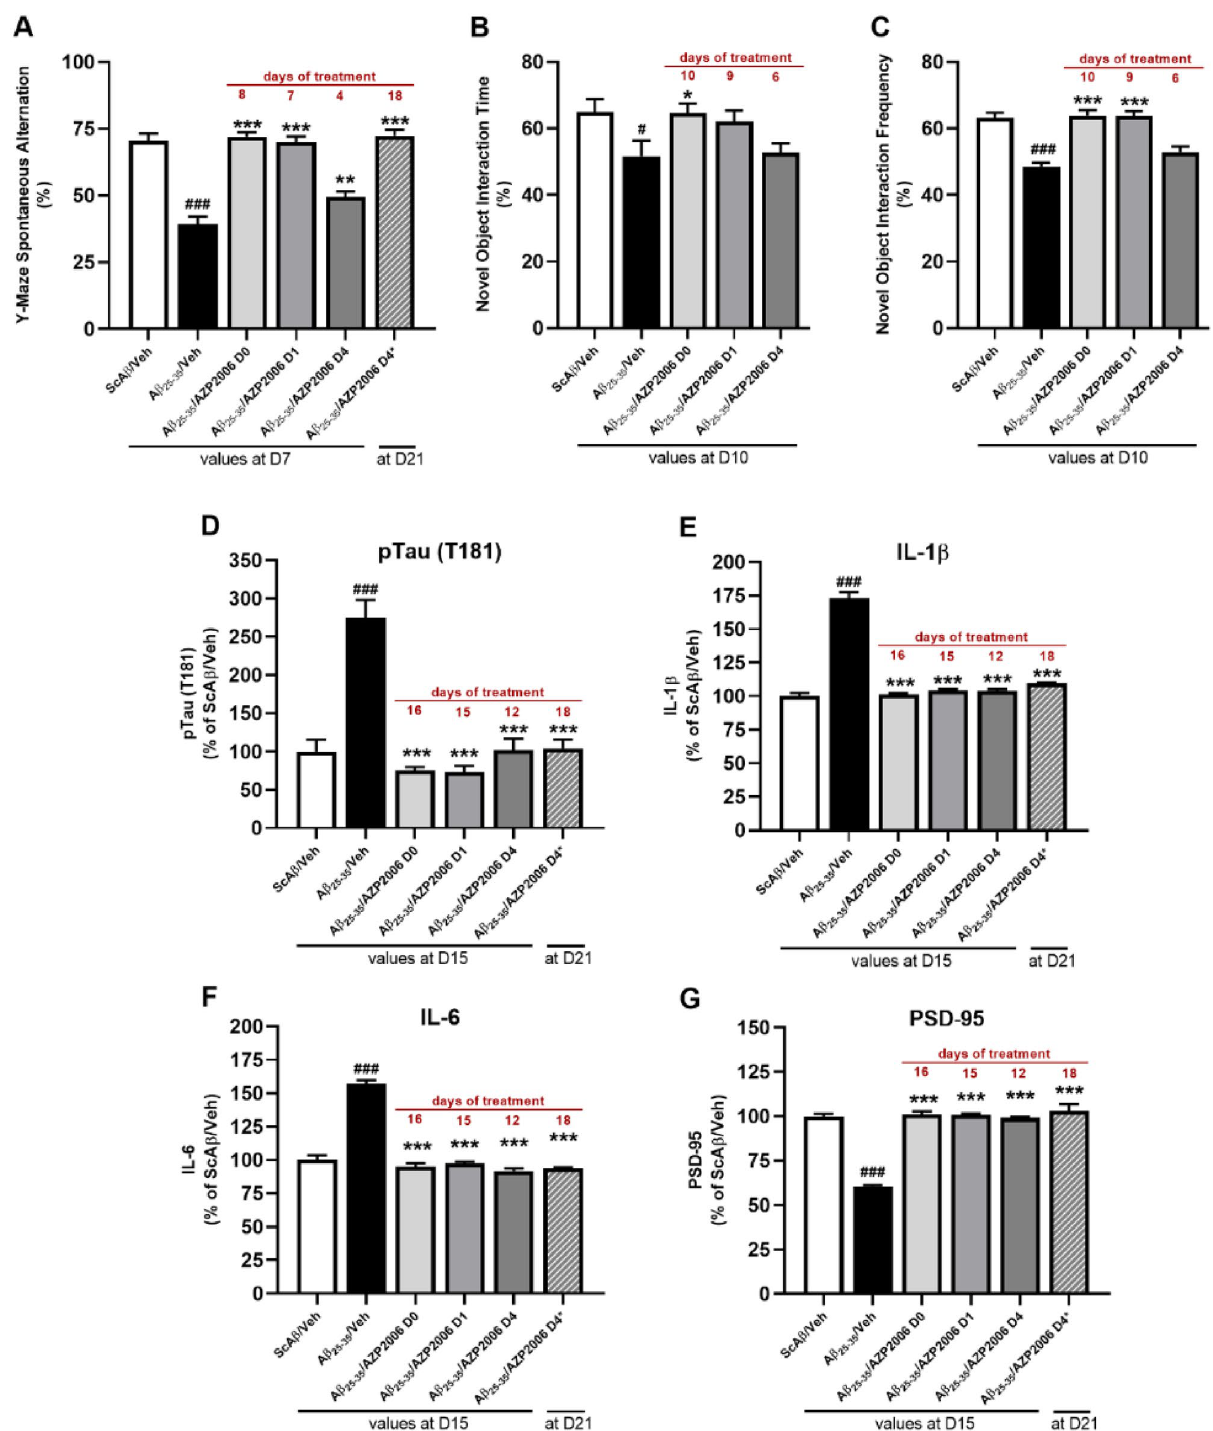
Figure 4. Effect of AZP2006 treatment on Aβ 25–35 injured mice. (A – C) Effect of AZP2006 on learning and memory impairments in the C57B/6Rj mice injured by Aβ 25–35 injection. Mice were daily treated with vehicle (water, D0) or AZP2006 by gavage (2 mg/kg) starting at: day 0 (Aβ 25-35 /AZP2006 D0), day 1 (Aβ 25-35 /AZP2006 D1), day 4 (Aβ 25-35 /AZP2006 D0), and day 4* (Aβ 25-35 /AZP2006 D4*). Treatment duration is shown in red. ( D ) Unilateral icv injection of Aβ 25-35 yielded a significant increase in pTau (T181) level in hippocampus when compared to ScAβ/Veh control mice, which was rescued by AZP2006 treatment. ( E – G) cortex concentrations of IL-1β, IL-6 and PSD-95 proteins measured by ELISA. Results expressed in % of ScAβ/Veh (control group) show the mean ± SEM (standard error of the mean). One-way ANOVA followed by Fisher’s LSD test, n = 10/group. # p < 0.01 or ### p < 0.001 versus ScAβ/Veh; * p < 0.05, ** p < 0.01 or *** p < 0.001 versus Aβ 25-35 /